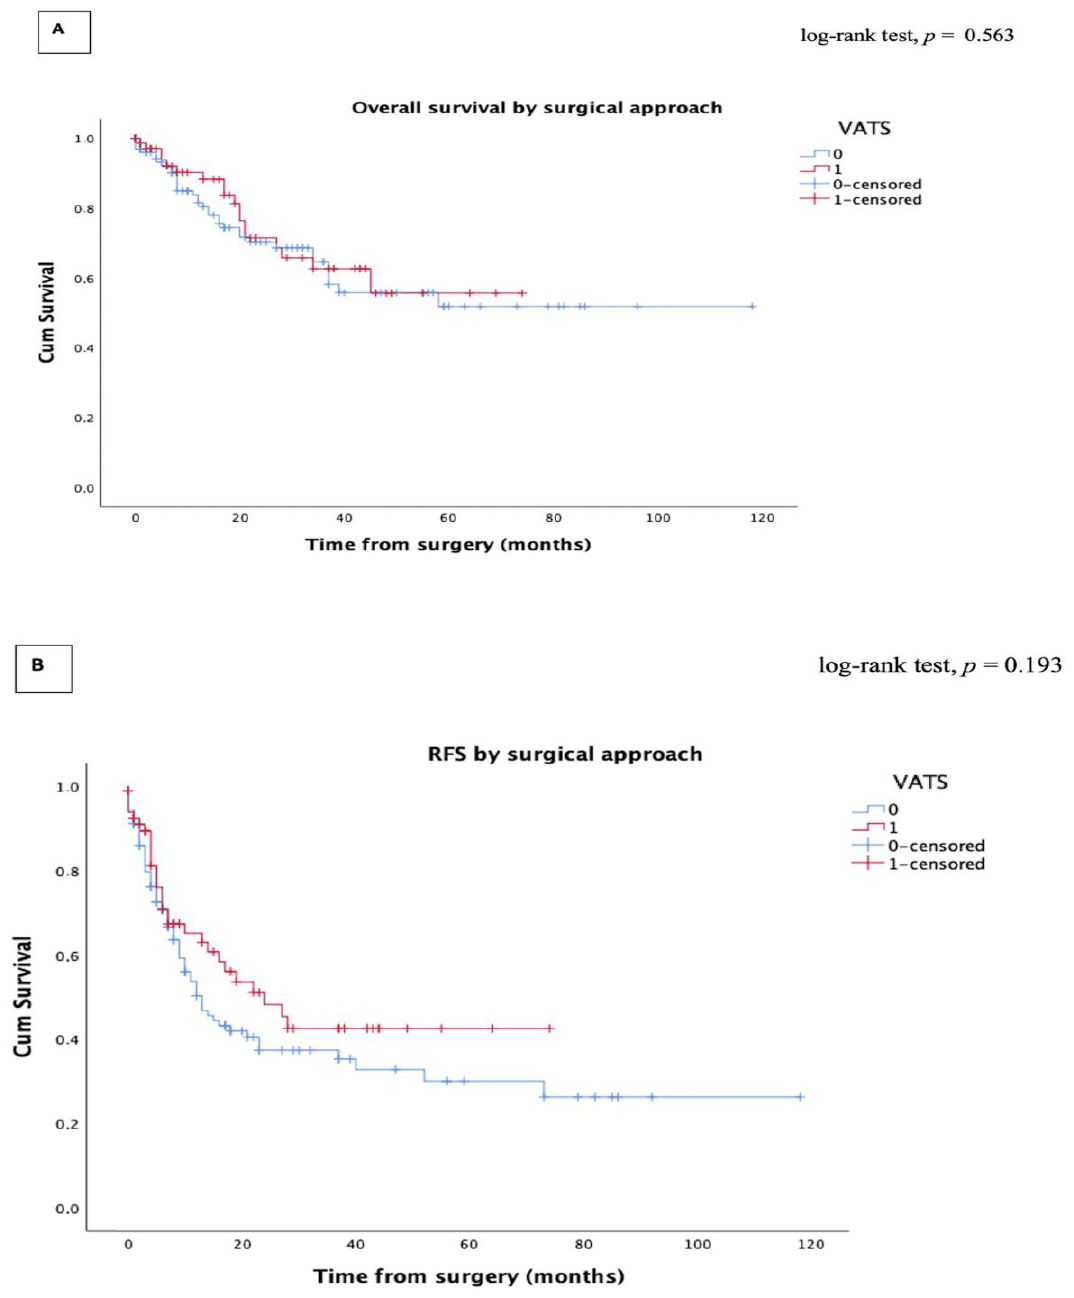
Figure 1. Kaplan–Meier curve for the long-term survival of the entire cohort. ( A ) Overall survival; Figure 1. Kaplan – Meier curve for the long-term survival of the entire cohort. A : Overall survival; B : ( B ) Recurrence-free survival. VATS: Video-assisted thoracoscopic Recurrence-free survival. VATS: Video-assisted thoracoscopic surgery. Table 4. Patterns of recurrence of all included patients and PSM pairs.